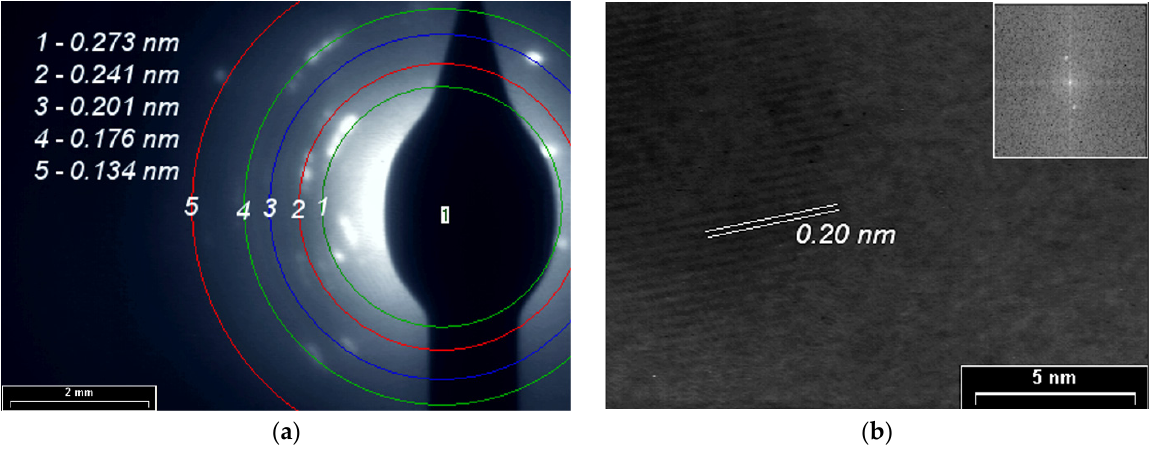
Figure 9. ( a ) SAED pattern; ( b ) HR-TEM images and in inset the fast Fourier transform (FFT) pattern of the PDPA film.